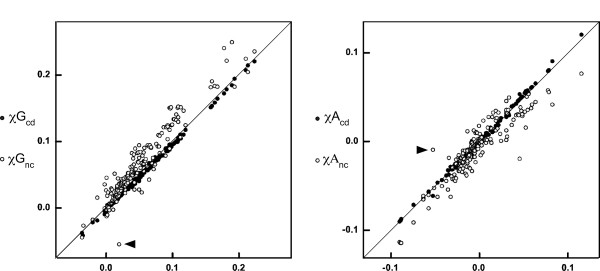
Comparison of base composition skews in the CDS and non-CDS. (A) The χG's are plotted against χGcd's (filled circles) and χGnc's (open circles). (B) χA's are plotted against χAcd's (filled circles) and χAnc's (open circles).